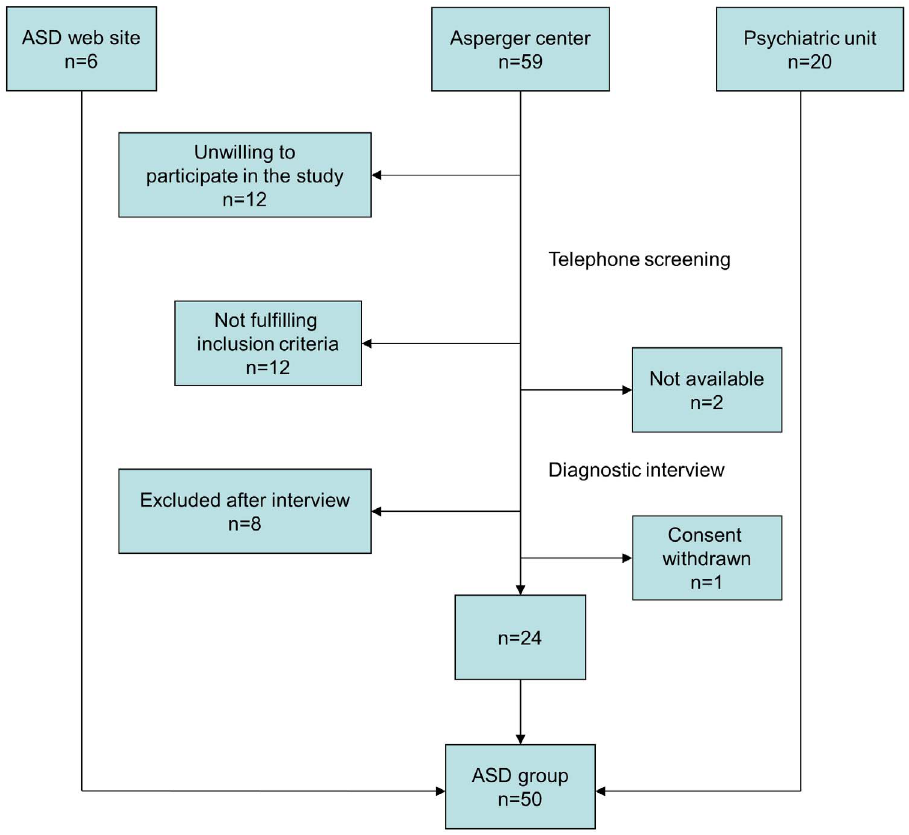
Figure 1. Flow chart for recruitment of participants with autism spectrum disorder. doi:10.1371/journal.pone.0087961.g001 PLOS ONE |